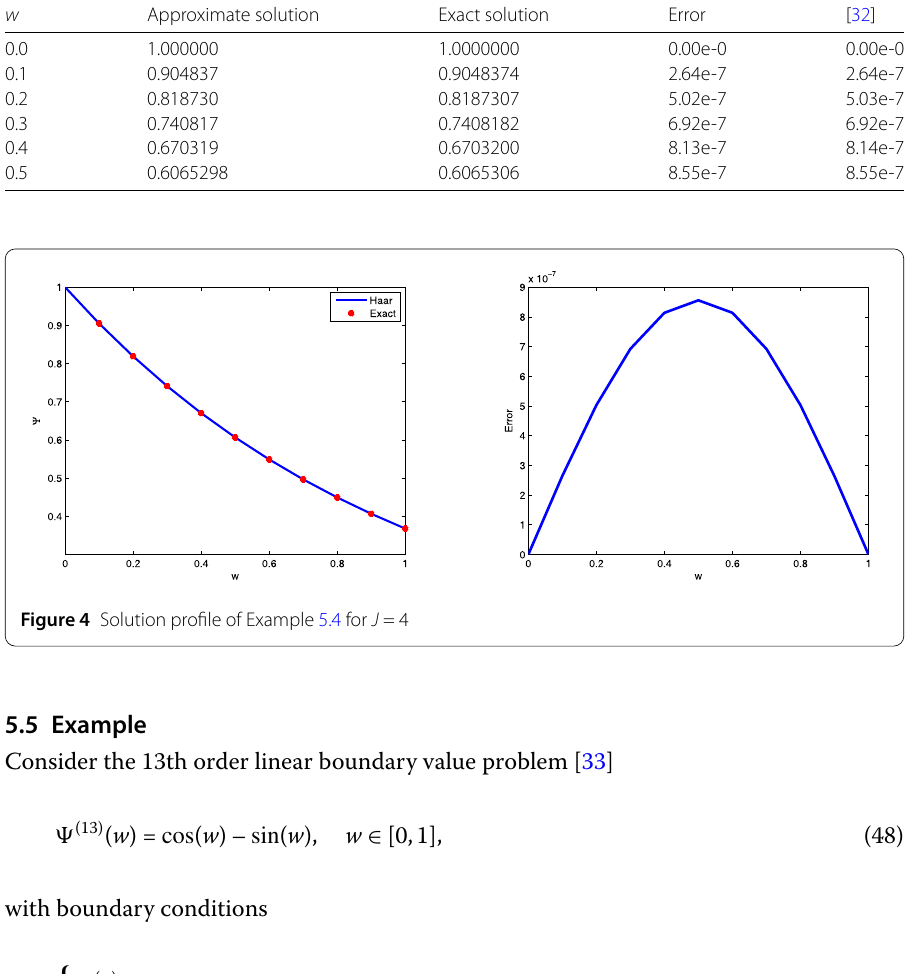
Table 4 Comparison of approximate and exact solution and absolute error of Example 5.4 when J = 4 w Approximate solution Exact solution 0.0